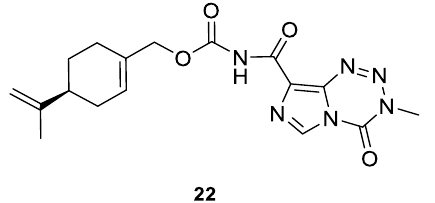
Figure 10. The structural formula of NEO212.